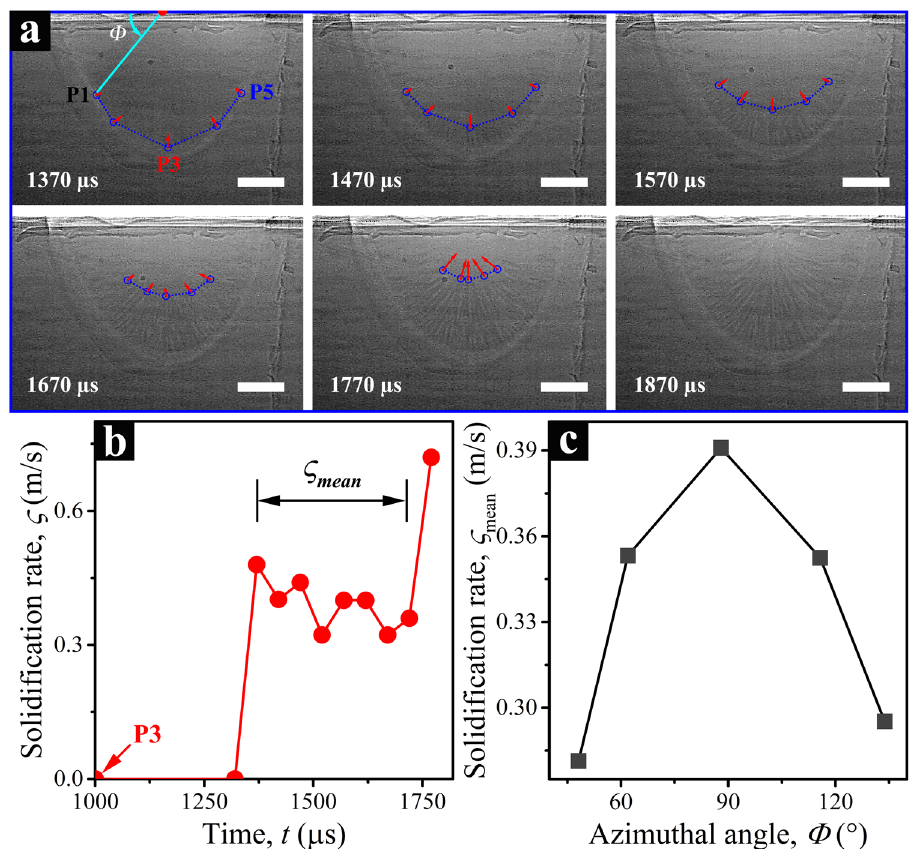
Figure 5. Measurement of the solidification rate of a Ti-6Al-4V plate sample in laser melting process. ( a ) Dynamic X-ray images of the solidification process collected at t = 1370, 1470, 1570, 1670, 1770, and 1870 µ s. Note the laser was turned off at t = 1000 µ s. The red dot at the top of ( a ) locates the center of the melt pool. The blue circles are the target points on the liquid-solid interface for tracking, and are connected by blue dotted lines to outline the melt pool boundary. The red arrow on each spot indicates the solidification velocity. All the scale bars are 100 µ m. ( b ) Solidification rate of target point P3 as a function of time. The solidification rate is calculated over the time unit of 50 µ s. ( c ) Mean solidification rate as a function of the azimuthal angle. The mean solidification rate is averaged over the equilibrium growth period shown in ( b ), and the azimuthal angle is defined in ( a